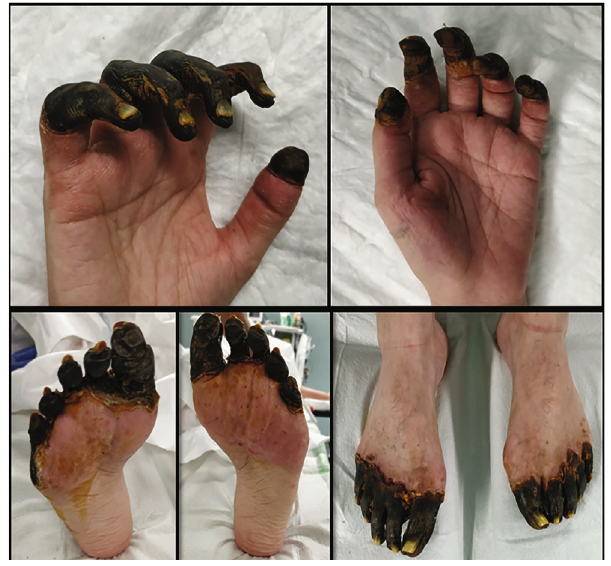
Figure 1: Case 1 lesions.